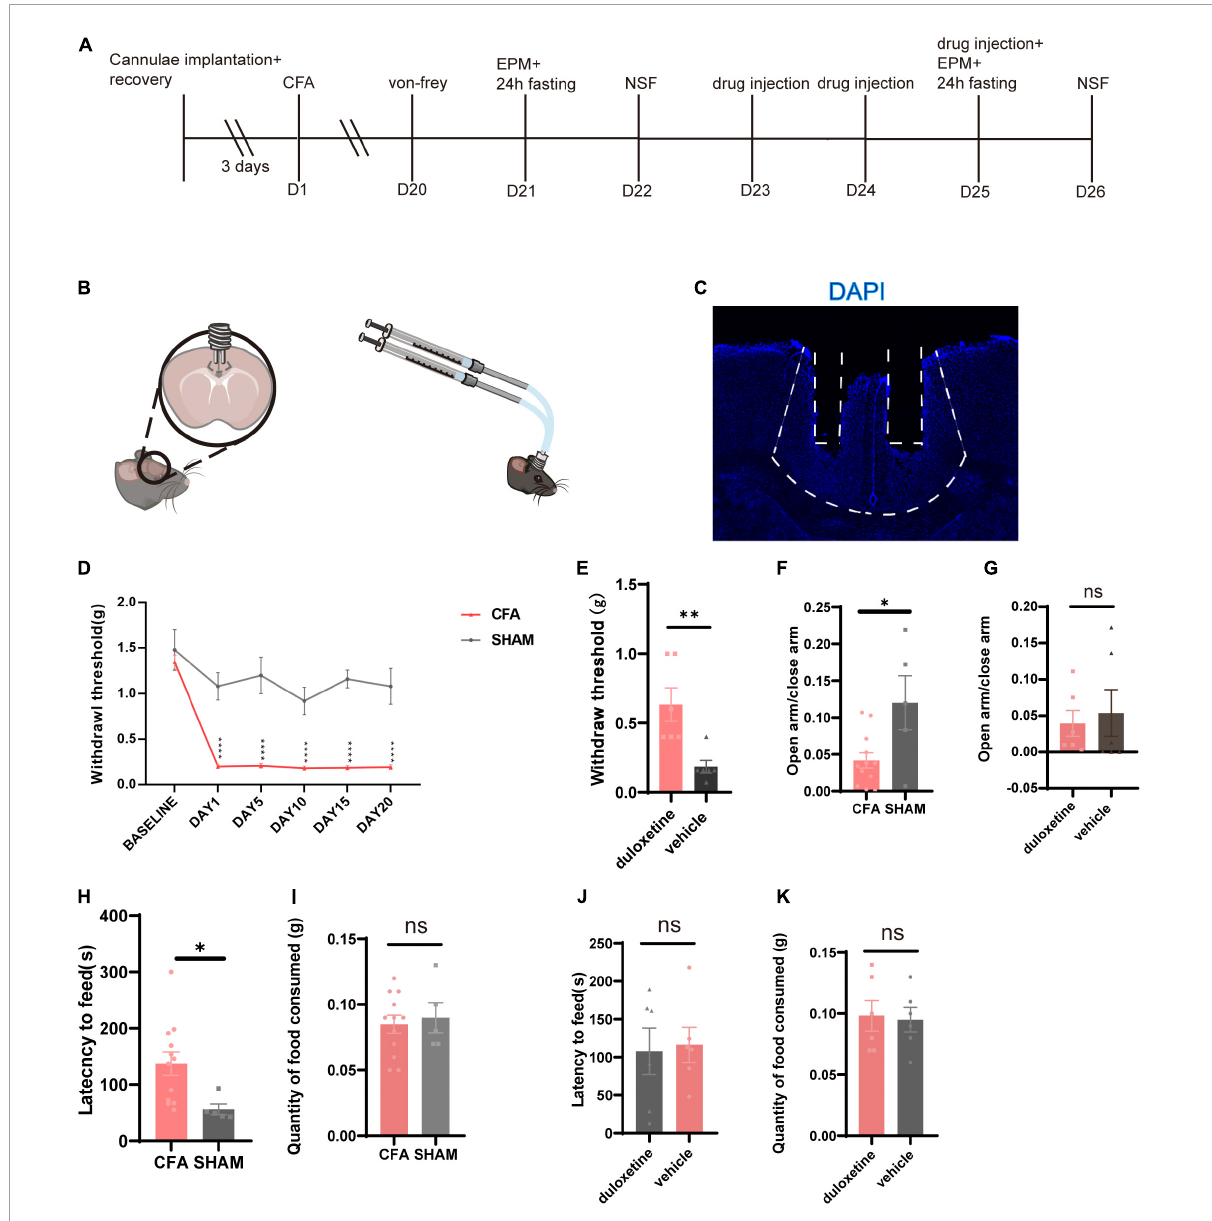
FIGURE4 Intra-anterior cingulate cortex (ACC) duloxetine improved mechanical withdrawal threshold but had no effect on anxiety-like behaviors in mice with chronic inflammatory pain. (A) Timeline of cannula implantation, CFA injection, behavioral tests, and drug infusion. (B) Cannula implantation and local infusion. (C) Representative brain slice of cannulae implantation in ACC. (D) Withdrawal threshold of CFA and SHAM groups during the modeling process (CFA: n = 26, SHAM: n = 5 baseline p = 0.7398 days 1–20: p < 0.0001, Mann–Whitney test). (E) Withdrawal threshold of duloxetine and saline group after a 3-day local infusion ( n = 6, p = 0.0087, Mann–Whitney test). (F) The ratio of time in the open arm and time in the closed arm of CFA and SHAM groups 21 days after the first CFA injection (CFA: n = 12, SHAM: n = 5, p = 0.0131, unpaired t -test). (G) The ratio of time in the open arm and time in the close arm of duloxetine and vehicle groups after local infusion ( n = 6, p = 0.7064, unpaired t -test). (H) Latency to feed of CFA and SHAM groups (CFA: n = 12, SHAM: n = 5, p = 0.0290, unpaired t -test) and (I) quantity of food consumed in a home cage feeding test 21 days after the first CFA injection (CFA: n = 12, SHAM n = 5, p = 0.8291, unpaired t -test). (J) Latency to feed of duloxetine and vehicle group ( n = 6, p = 0.7020, unpaired t -test) and (K) quantity of food consumed in home cage feeding test after a 3-day local infusion ( n = 6, p = 0.8387, unpaired t